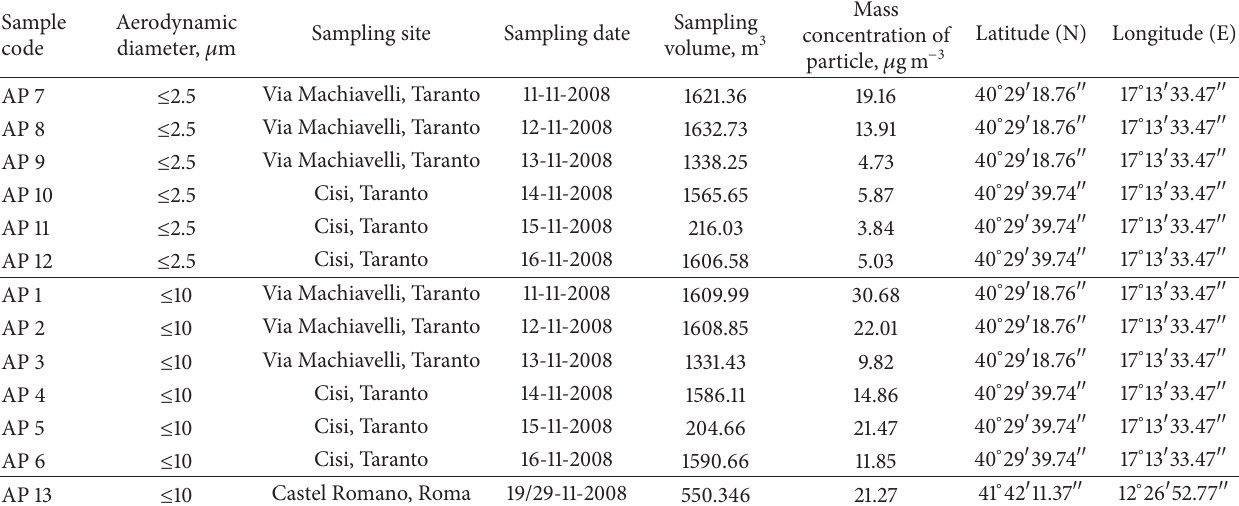
Table 2: Characteristics of the sampling sites for atmospheric particulate (AP) collected in the sampling campaign of November 2008 (the